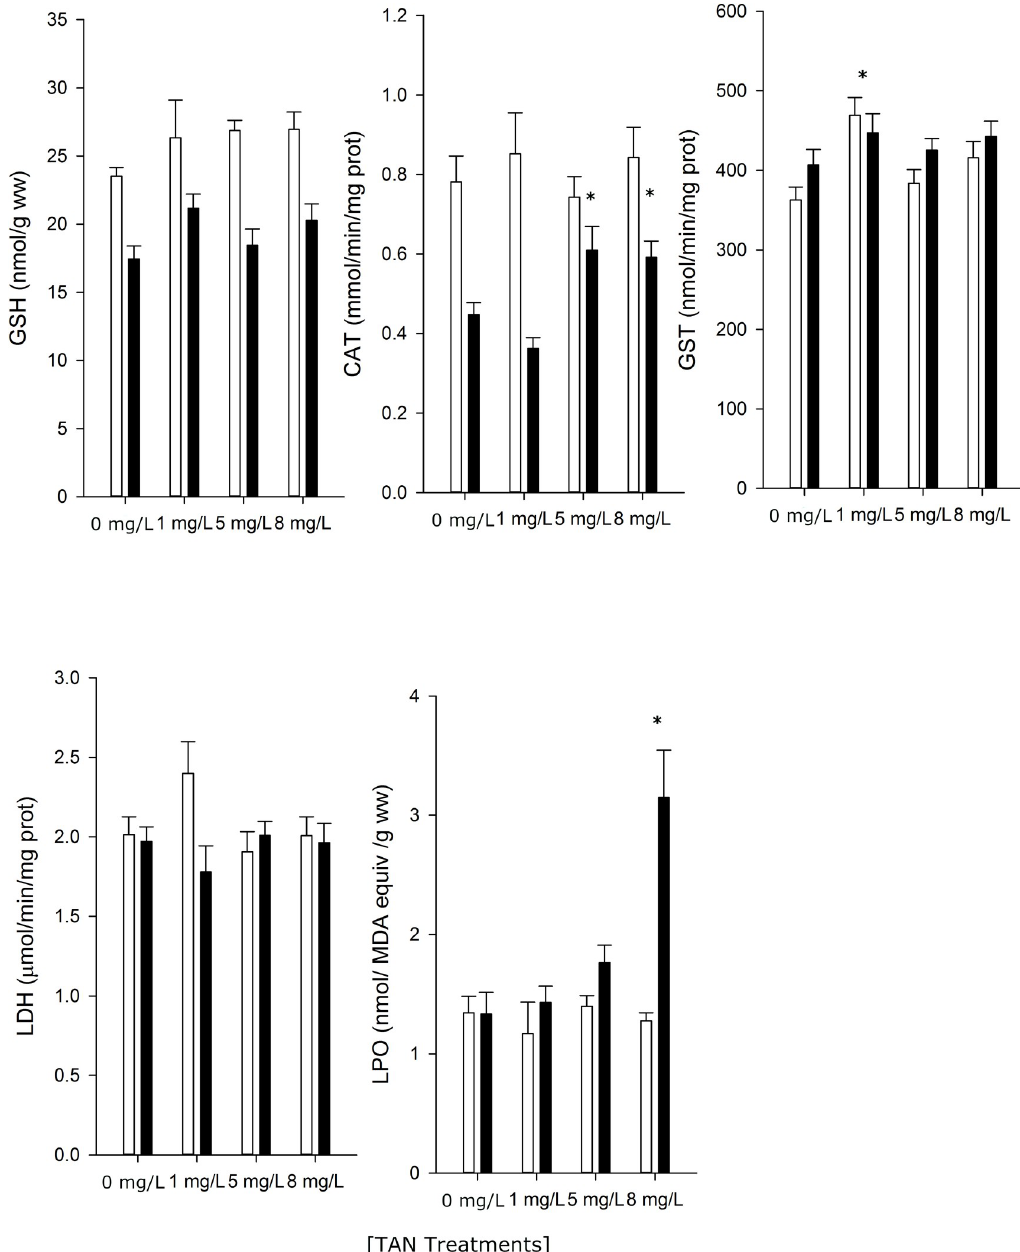
Fig 4. Antioxidant and oxidative stress responses (mean ± SE, n = 10) of B . meridionalis exposed to increasing TAN concentrations during the experiment. Black and white bars indicate the results for the fish from the polluted site (pre-exposed fish) and the unpolluted site (non pre-exposed fish), respectively. � indicates significant differences ( P < 0.05) within each site from control TAN treatment (0 mg/L TAN) following LM model and Dunnett’s post-hoc tests.